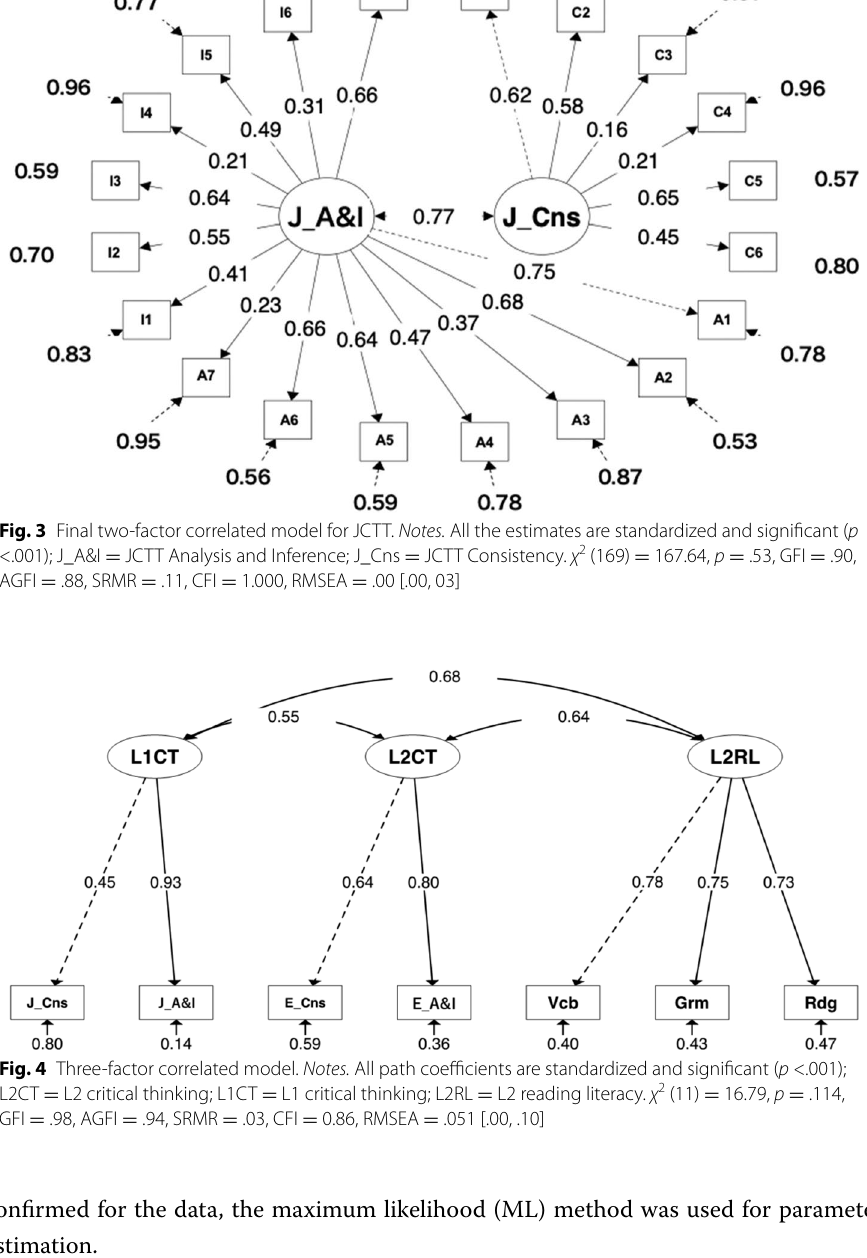
L2 reading literacy. χ 2 (11) = .051 [.00, =